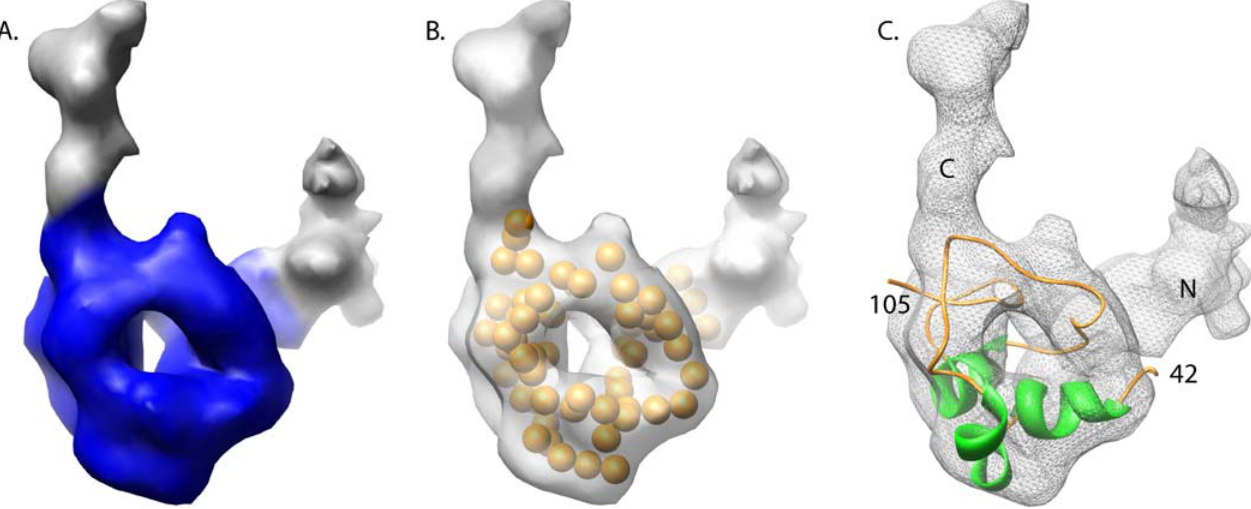
(A) The core domain of the segmented VP26 cryoEM density is colored in blue. (B) The pseudoatoms (orange spheres) assigned in the density-reduction step are shown superimposed on the cryoEM density of VP26. (C) The best model of the core domain (residues 42–105) generated by Rosetta and selected using cryoEM density constraints is shown fitted within the segmented VP26 density. The putative N-terminal and C-terminal density regions are labeled N and C,